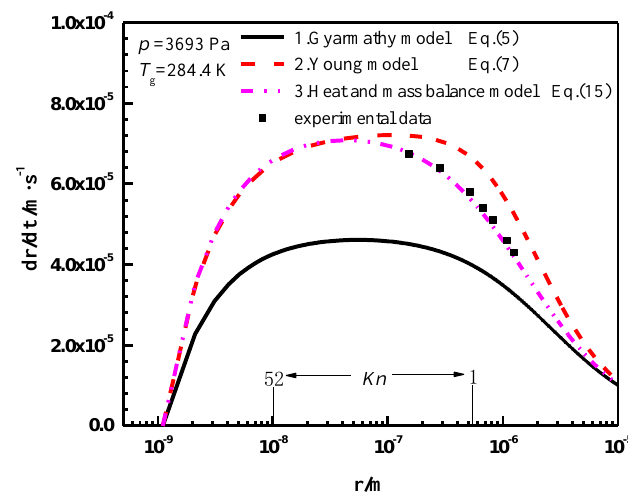
Figure 4. Comparison of the water droplet growth models.